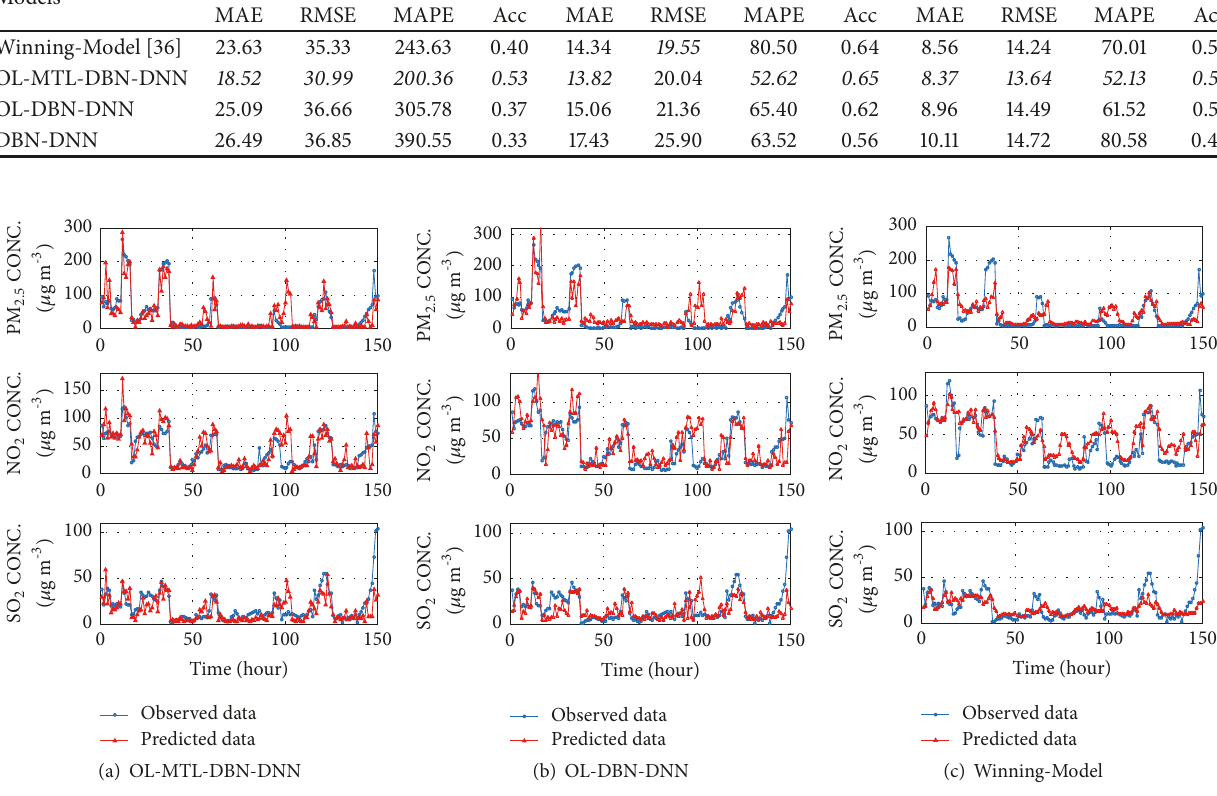
Figure 6: The prediction performances of different models for a 12-h horizon. In the pictures, time is measured along the horizontal axis and the concentrations of three kinds of air pollutants (PM 2.5 , NO 2 , SO 2 ) are measured along the vertical